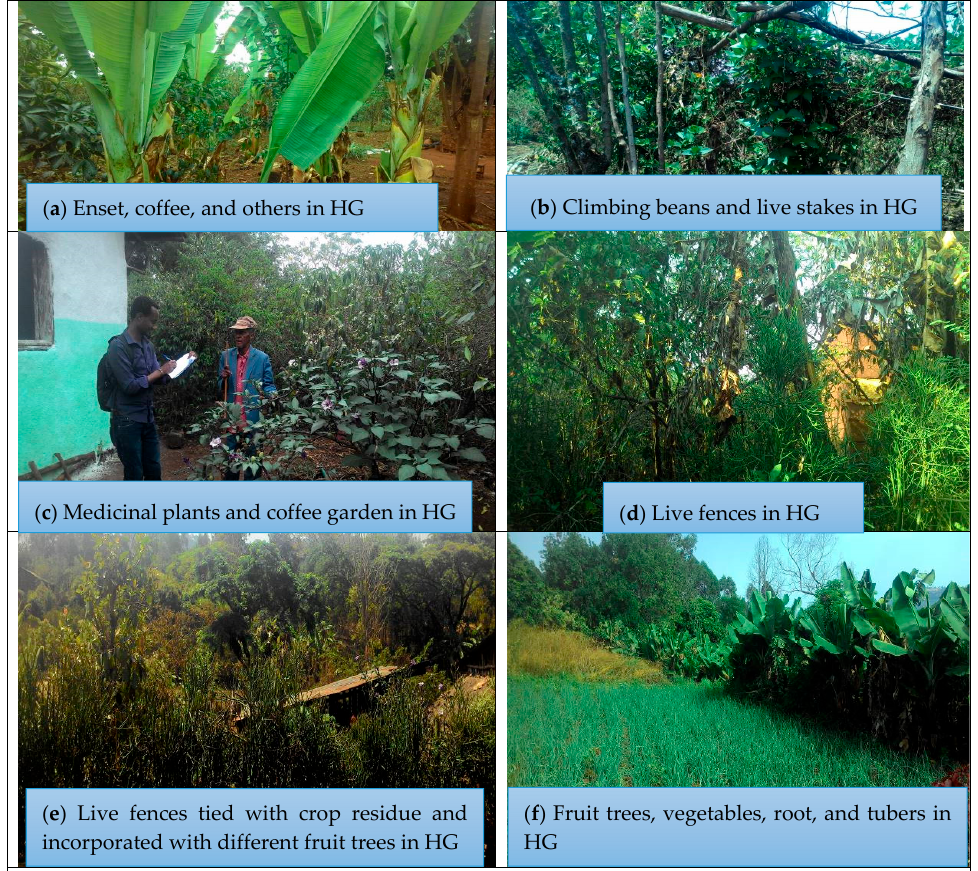
Figure 2. Homegardens (HG) and some compositions of them taken by the author, March